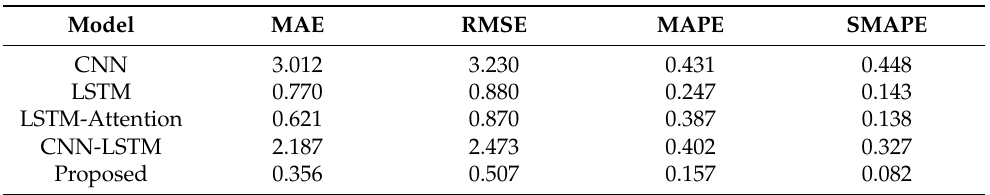
Table 3. Comparison of CNN, LSTM, LSTM-Attention, CNN-LSTM, and the proposed model for the four evaluation indicators of MAE, RMSE, MAPE, and